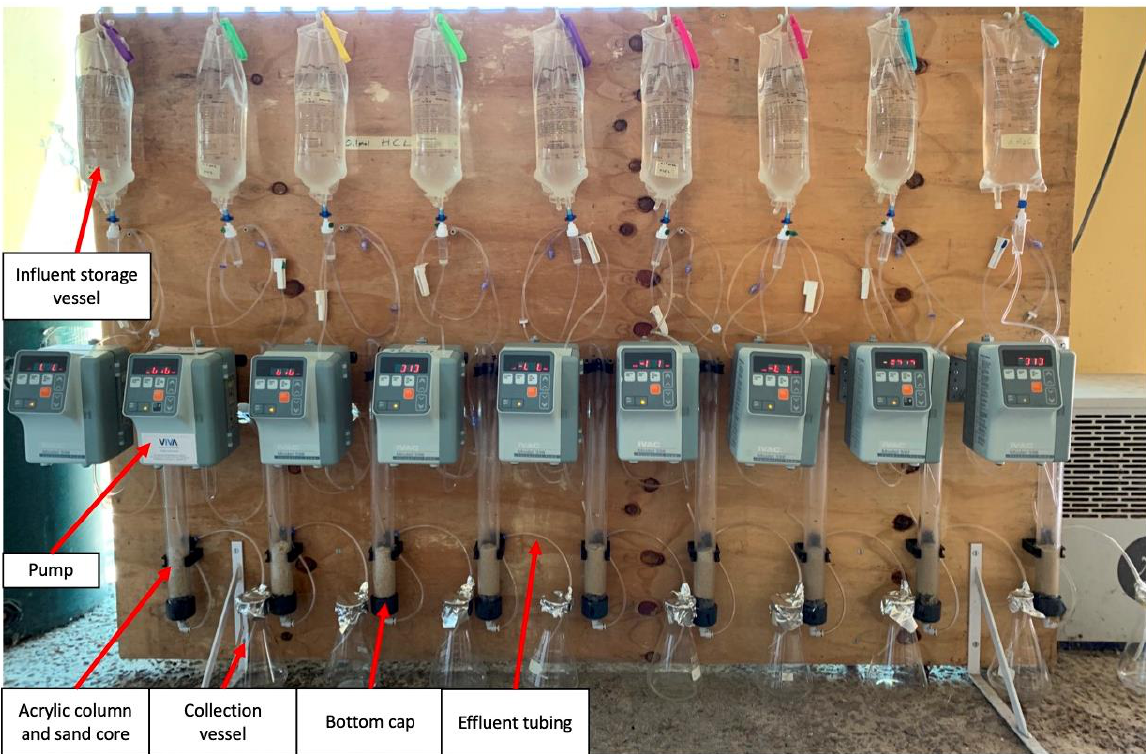
Figure 1. Experimental